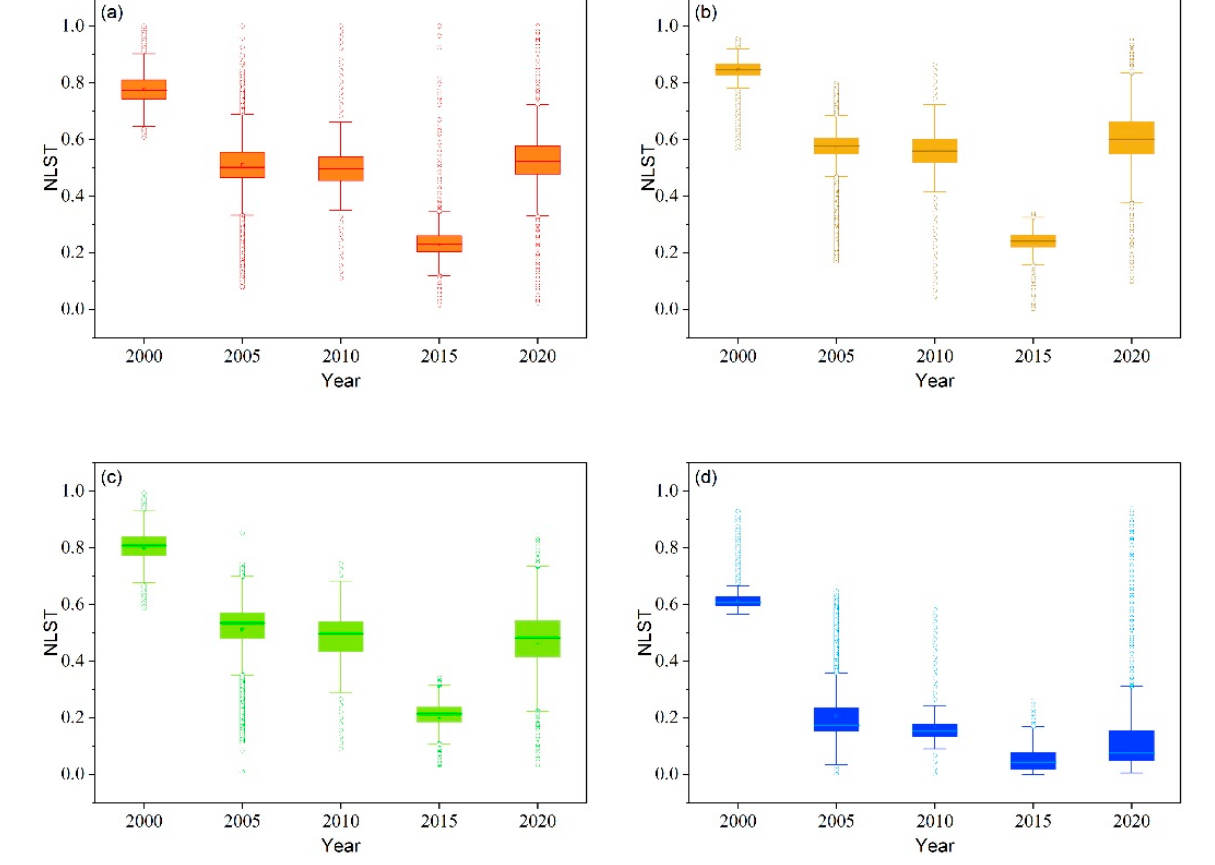
Figure 7. Box plots of normalized land surface temperatures for different land cover types: ( a ) built-up area, ( b ) bare land, ( c ) vegetation, and ( d ) water bodies.